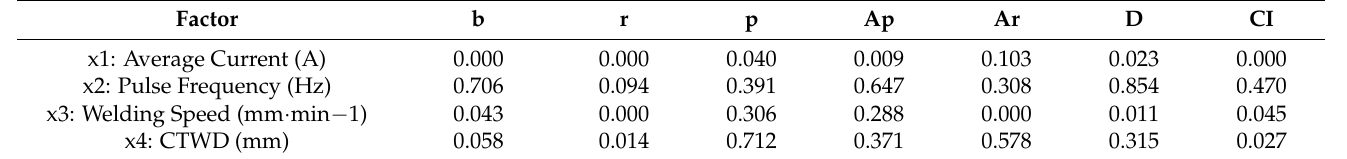
Table 6. Analysis of Variance (ANOVA) obtained through regression analysis for response variables ( p